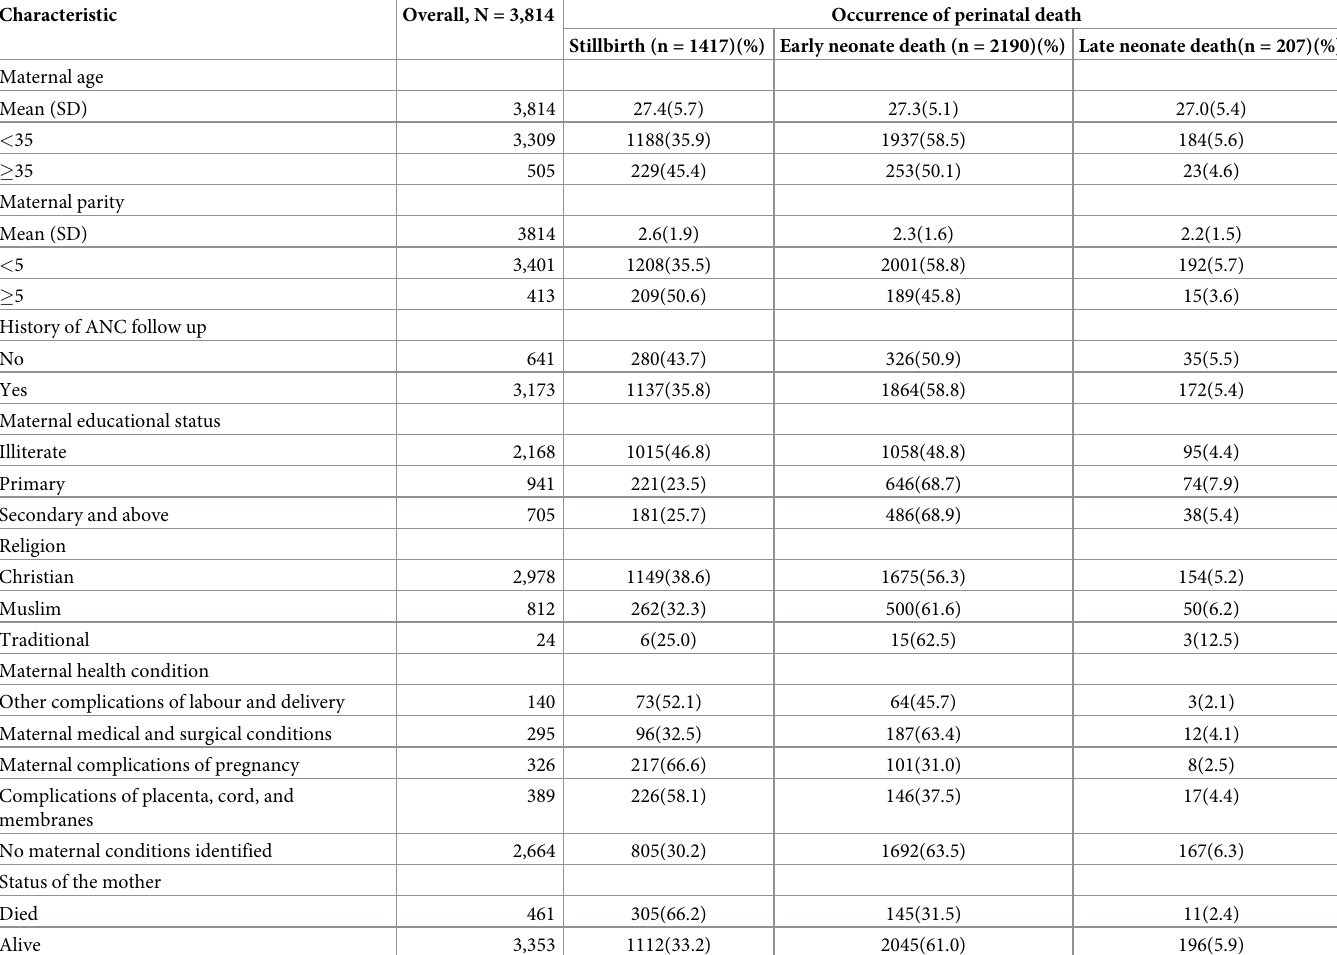
Table 5. Selected background characteristics of the deceased perinate’s mother by the timing of death in Ethiopia,2021.